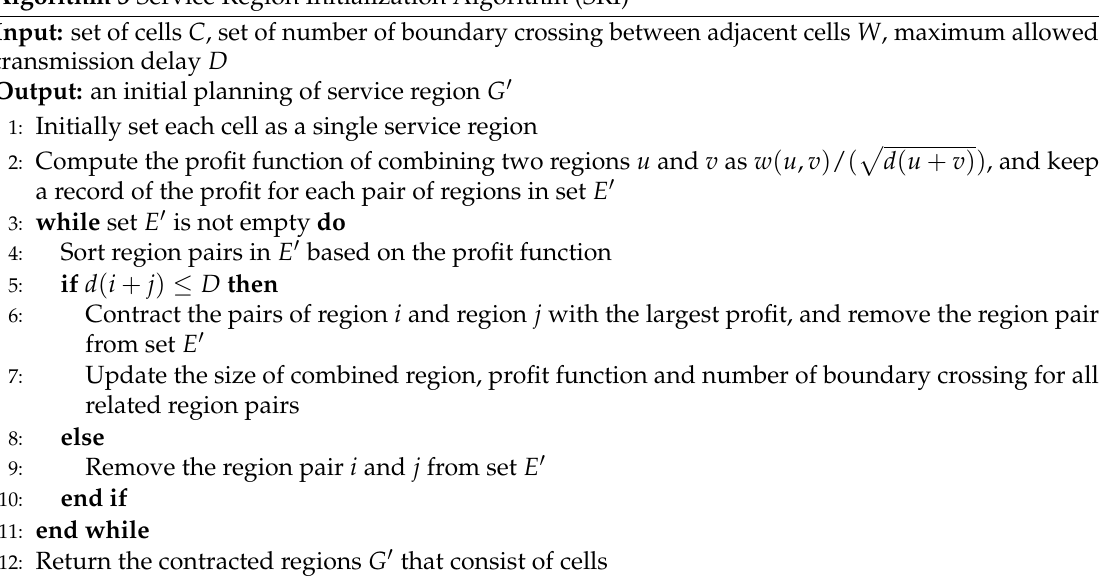
Algorithm 3 Service Region Initialization Algorithm